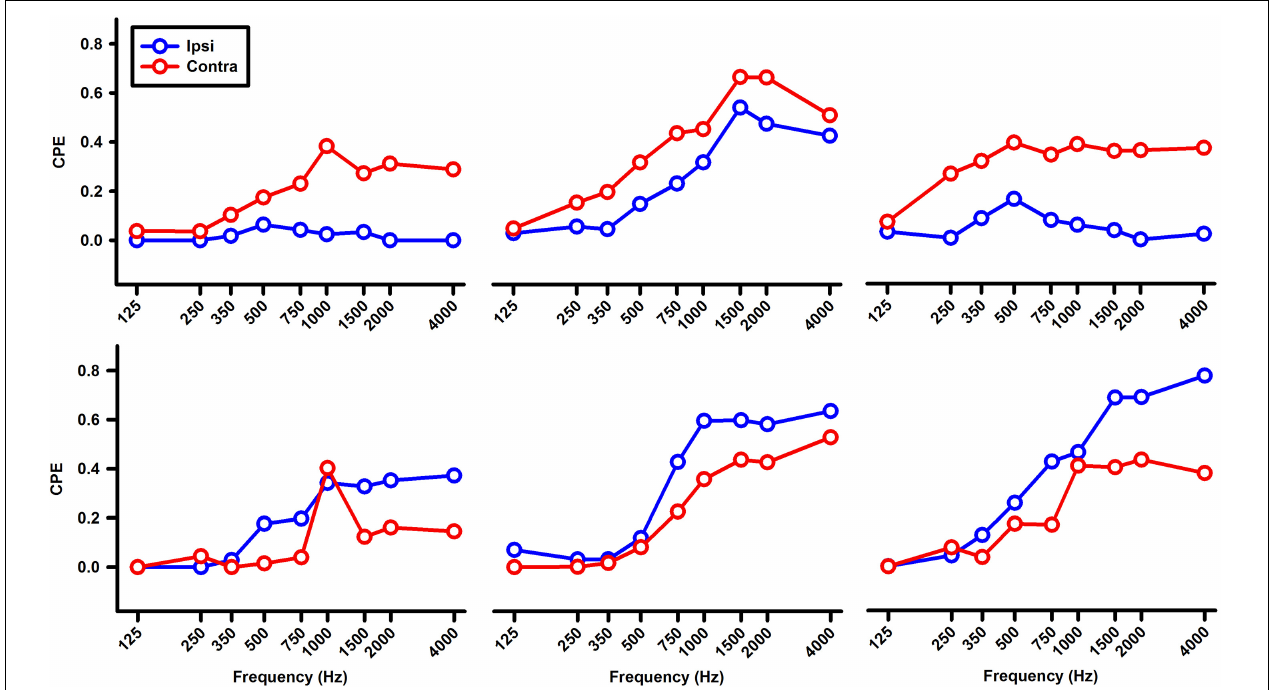
FIGURE 8 | Tuning curves of six abducens neurons for ipsilateral (blue) and contralateral (red) ear tone stimulation.